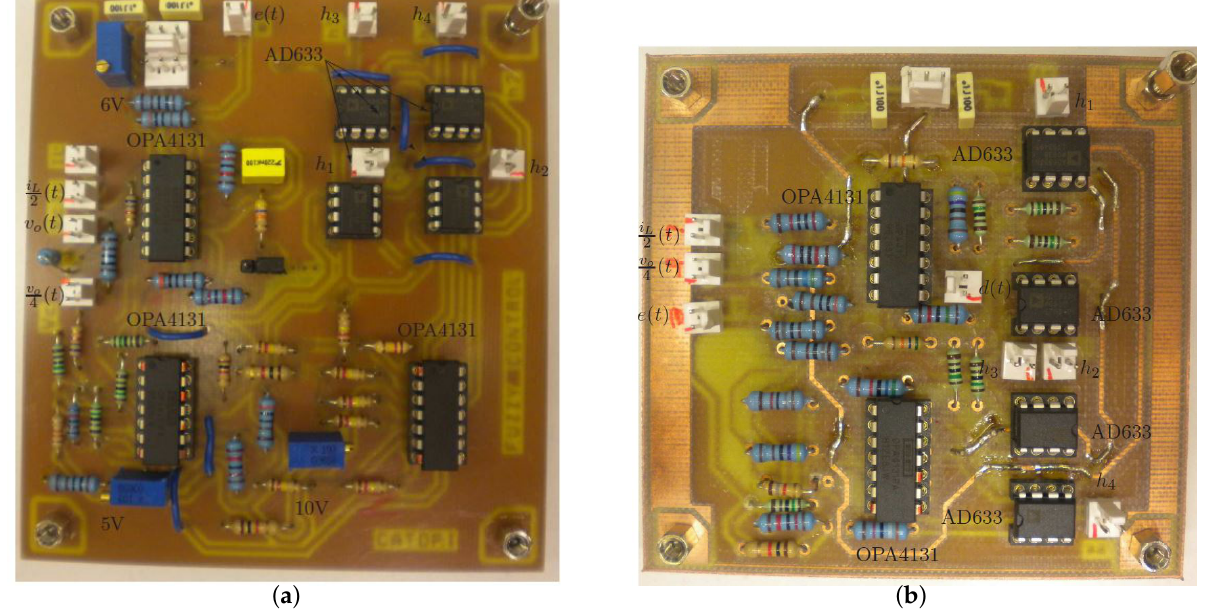
Figure 12. Practical LMI-Fuzzy control implementation. ( a ) Printed circuit board for the calculate membership functions and normalized weights. ( b ) Printed circuit board for the calculate total T-S fuzzy